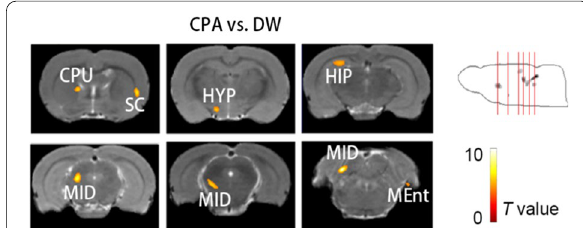
Fig. 5 The result of the increased 18 F-GE180 uptake in the CPA group rats compared with the withdrawal rats. The red lines on the MIP image refer to the location of the cross section images on the left, and the cross section images are arranged from front to back, left is left. The color bar represents the T value of each significant voxel. The abbreviation of each brain region is marked on the cross section images. CPU caudate putamen, SC sensory cortex, HYP hypothalamus, MID midbrain regions, MEnt medial entorhinal